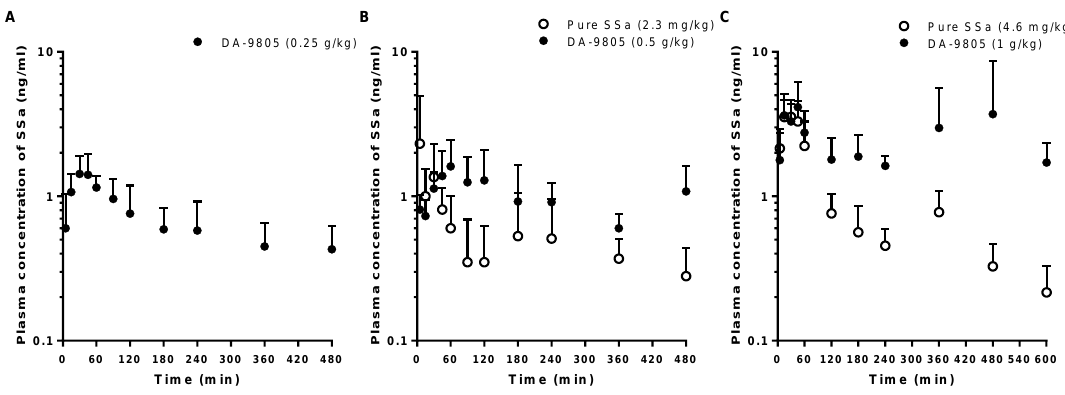
Figure 3. Mean arterial plasma concentration–time profiles of SSa following oral administration of DA-9805 (closed circle) at doses of 0.25 g/kg (( A ); 1.1 mg/kg as SSa, n = 5), 0.5 g/kg (( B ); 2.3 mg/kg as SSa, n = 5), and 1 g/kg (( C ); 4.6 mg/kg as SSa, n = 5) and pure SSa (open circle) at doses of 2.3 mg/kg (( B ); n = 4) and 4.6 mg/kg (( C ); n = 5) to rats. Vertical bars represent SD.